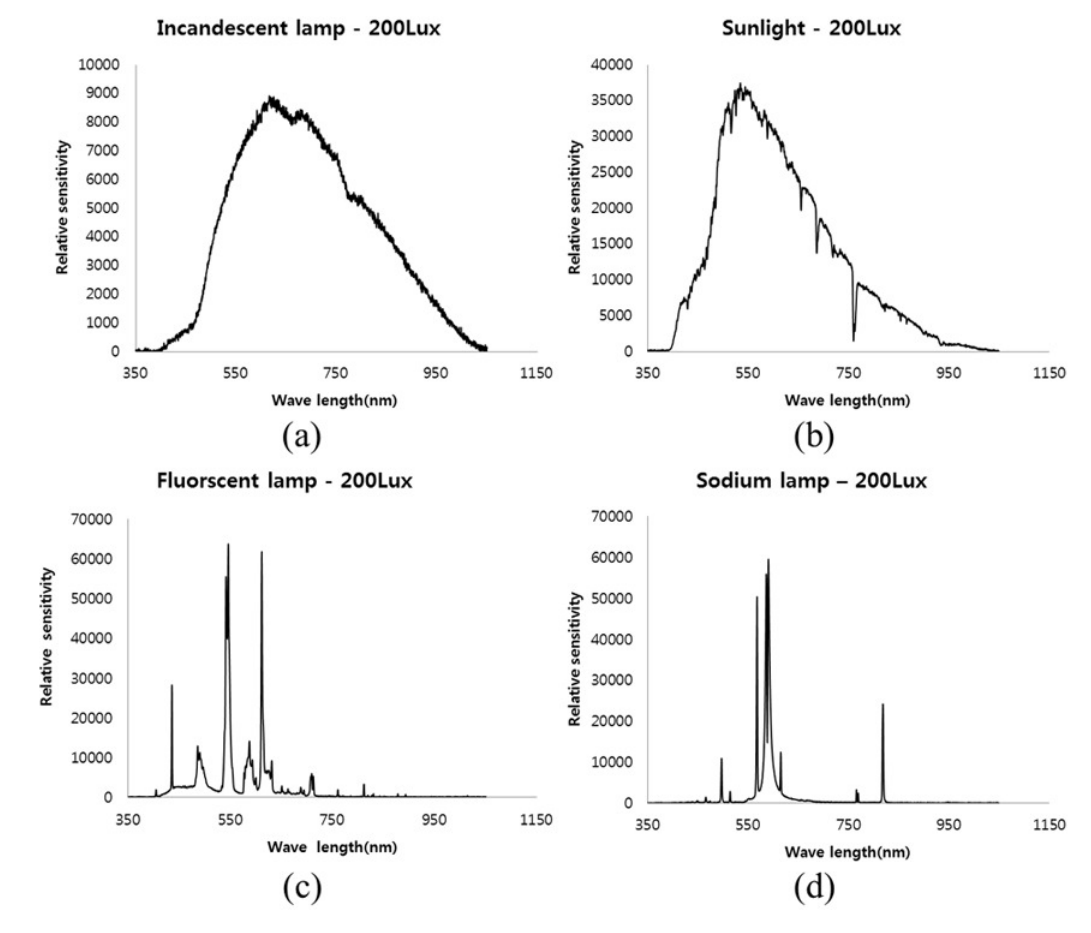
Figure 16. Spectral distribution of a variety of light sources. ( a ) Incandescent lamp (3000 K); ( b ) sunlight (6500 K); ( c ) fluorescent lamp (5000 K); ( d ) sodium lamp (2700